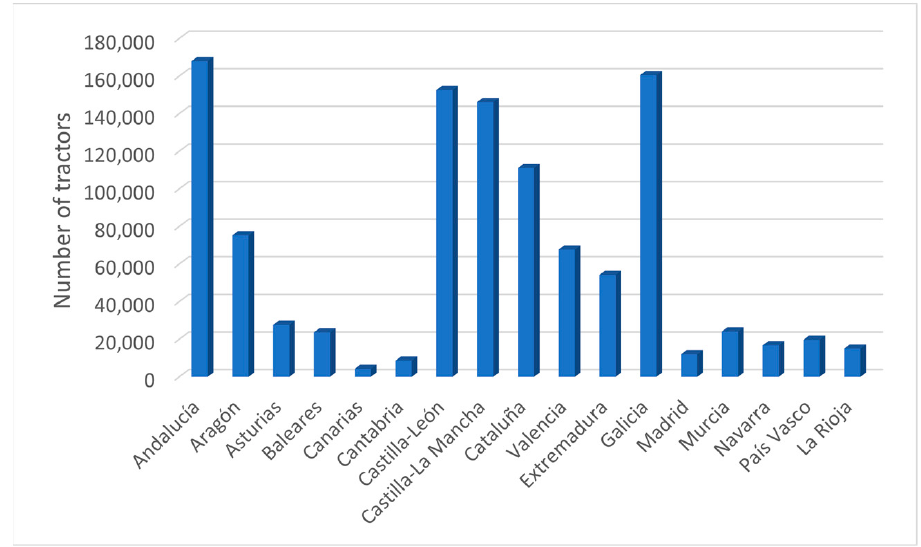
Figure 5. Average number of tractors registered in the ROMA in the period 2010-2019, by Autonomous Community.